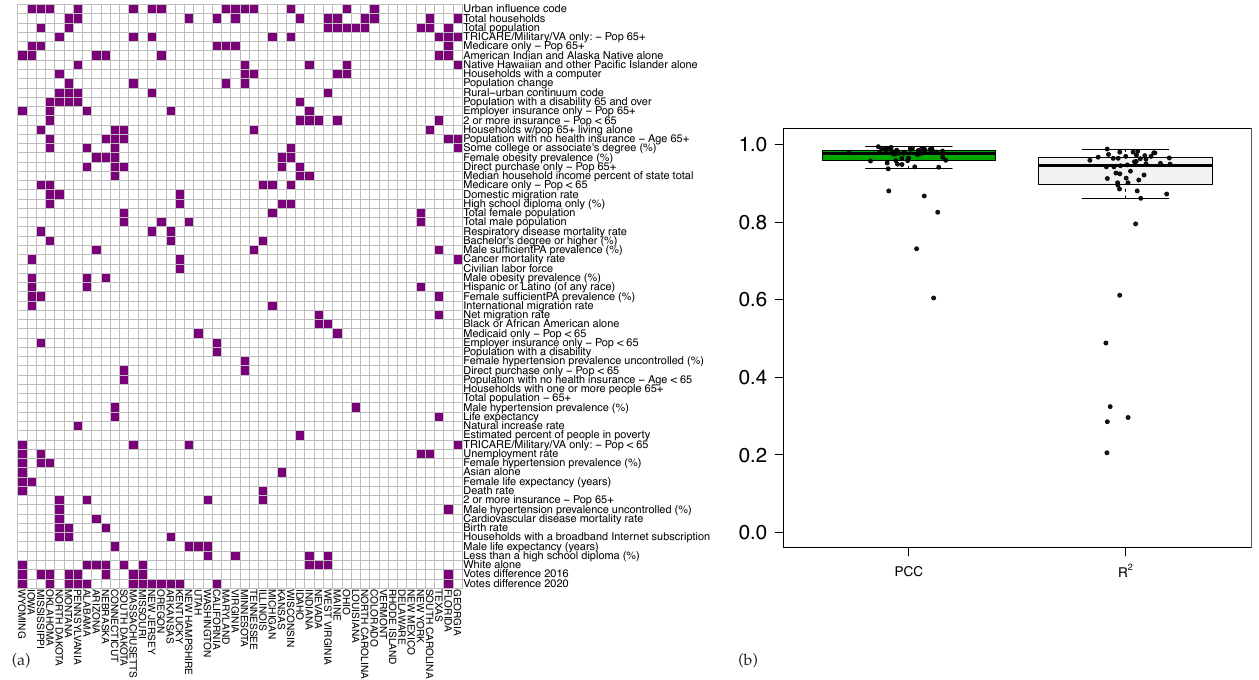
Figure A5. ( a ) Selected predictive features for each state by the algorithm for the nationwide phase prediction of cases. ( b ) PCC and R 2 values of the predictions reported as a box plot.